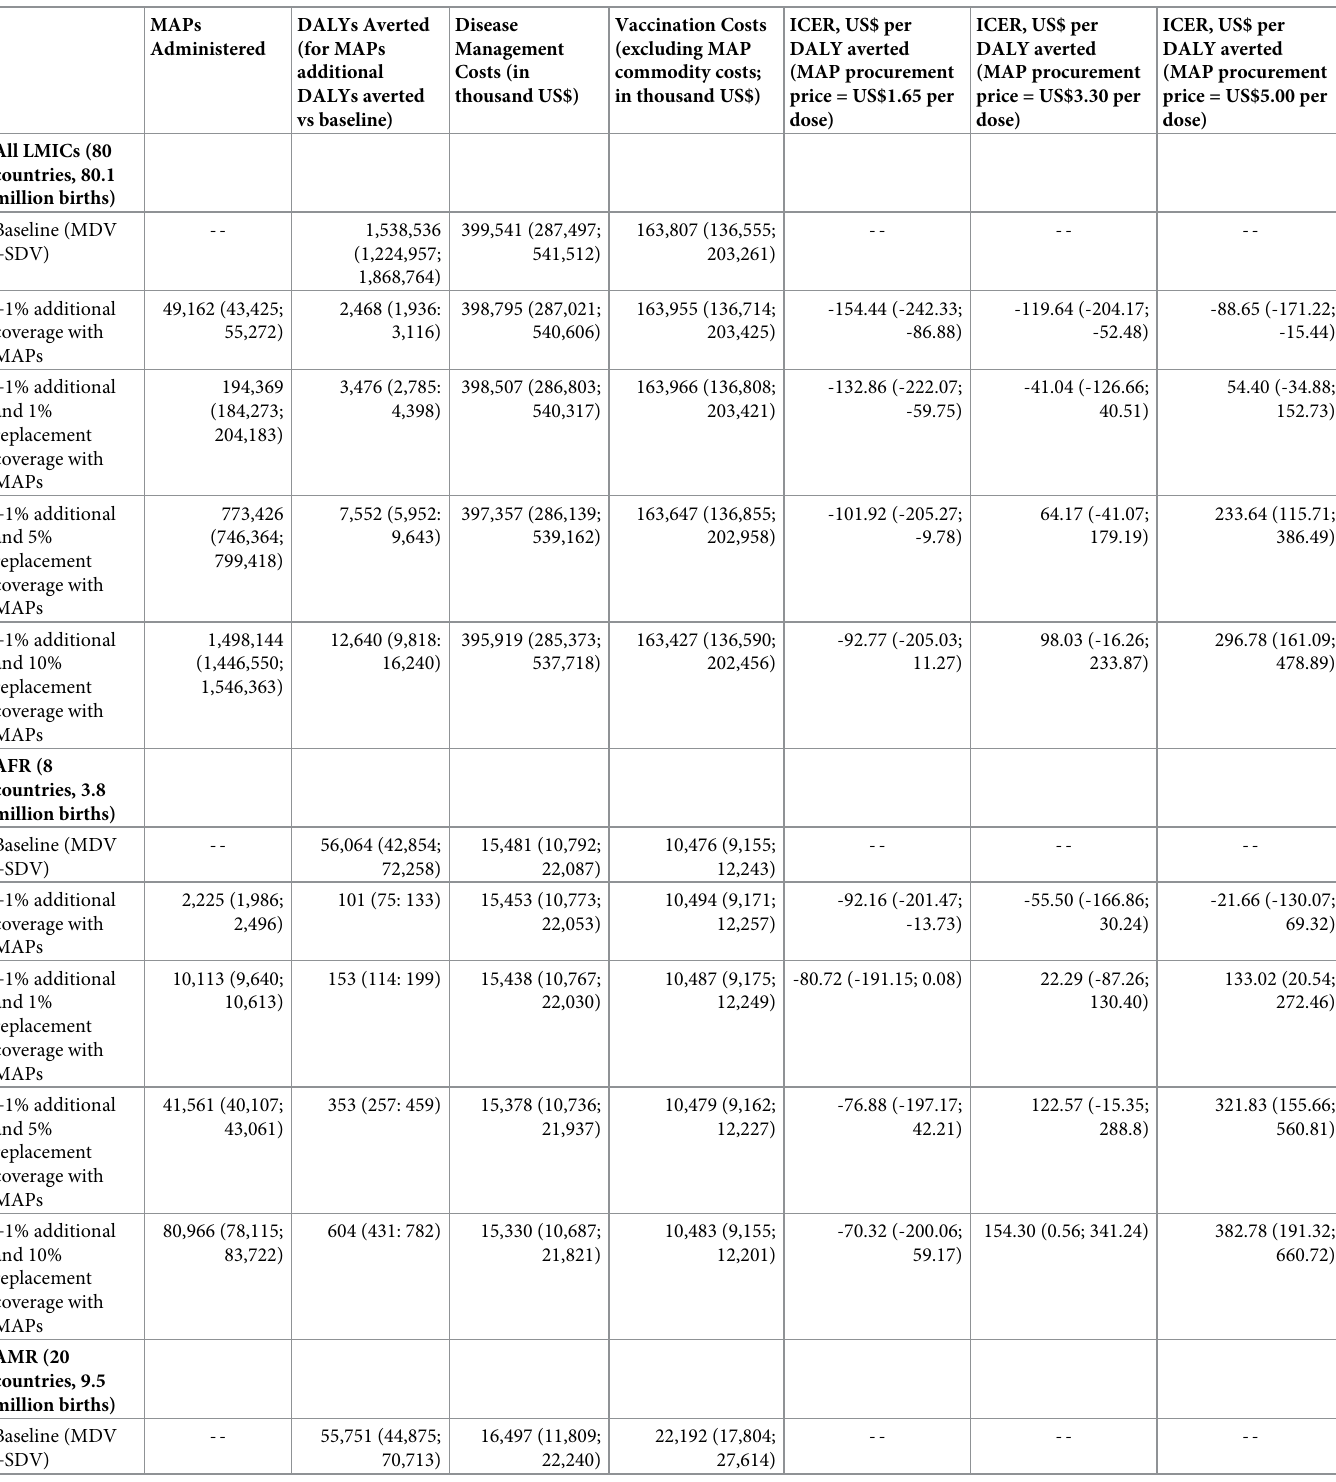
Table 3. Regional model outputs. MAPs